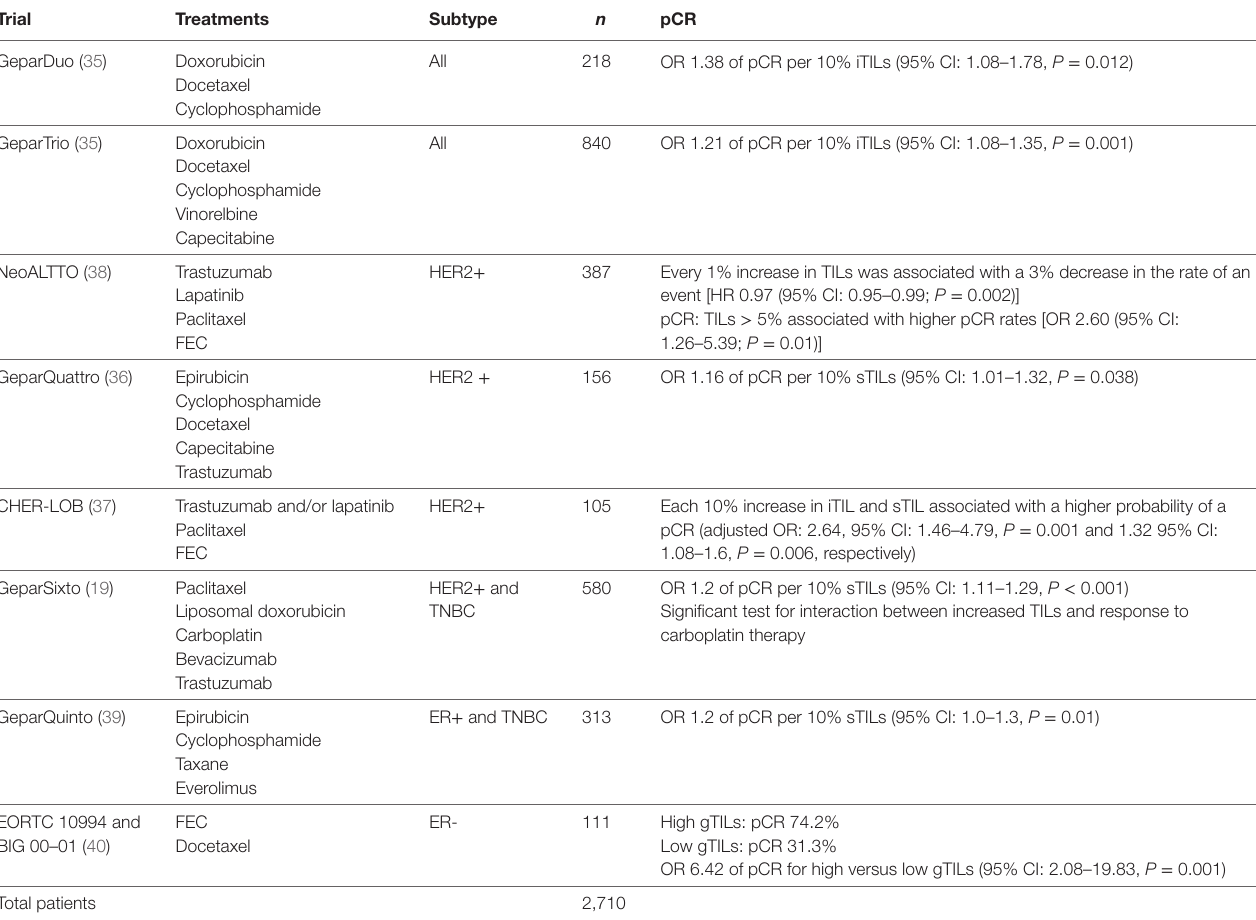
TABLe 2 | Neoadjuvant trials that have assessed tumor-infiltrating lymphocytes (TILs).